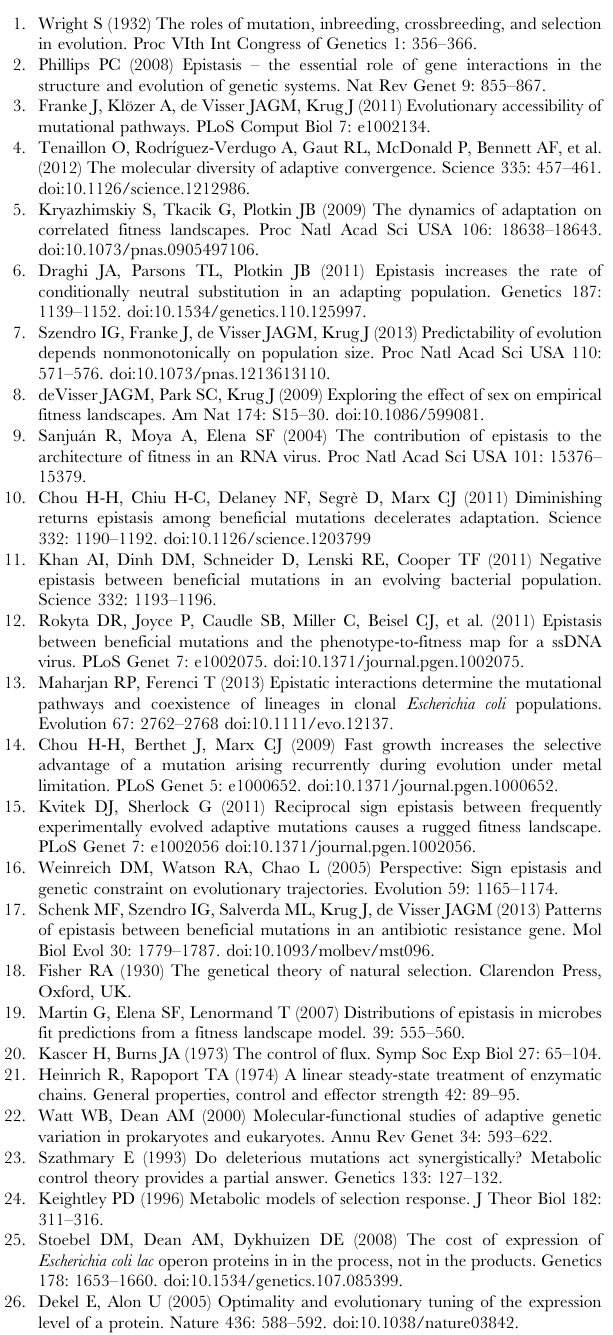
Table S1 Genotypes and phenotypes of pCM410, pHC112, and their derivatives. Table S2 Bacterial strains and plasmids. Table S3 The value of fitted parameters in the fitness landscape